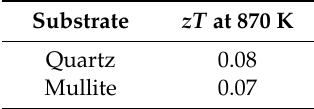
Table 3. Si/SiC ML on different